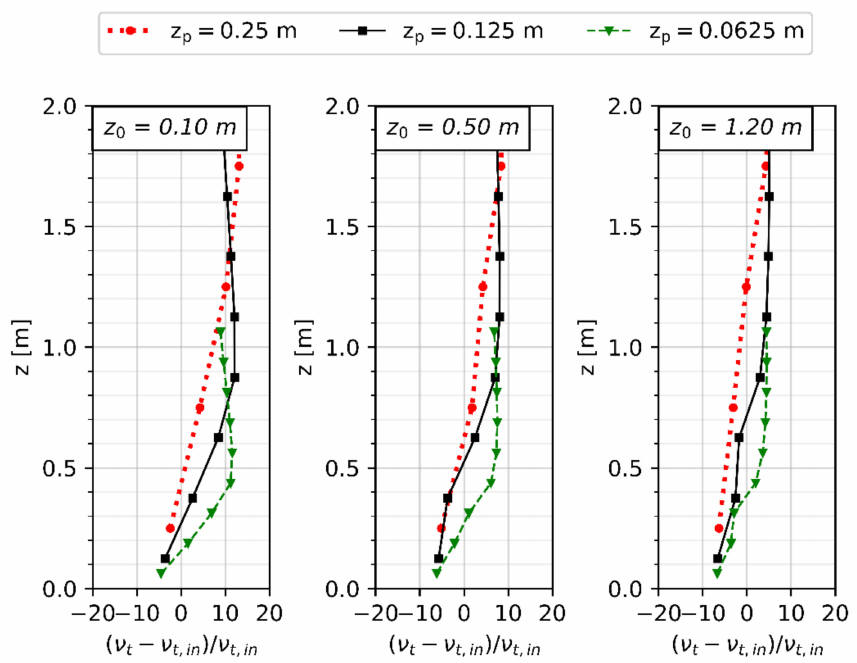
Figure 3. Eddy viscosity profiles at 300 m distance from the inlet for varying surface roughness and grid